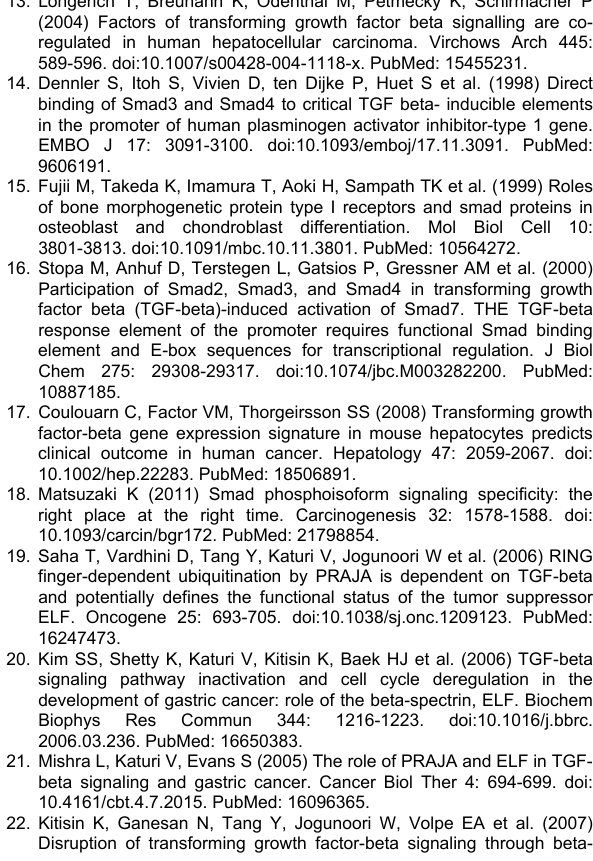
Figure S3. Densitometric analysis (ImageJ software) of Western Blots presented in Figure 2 and corresponding repetitive experiments. Results are shown as mean +/- SE of the indicated numbers of independent experiments.